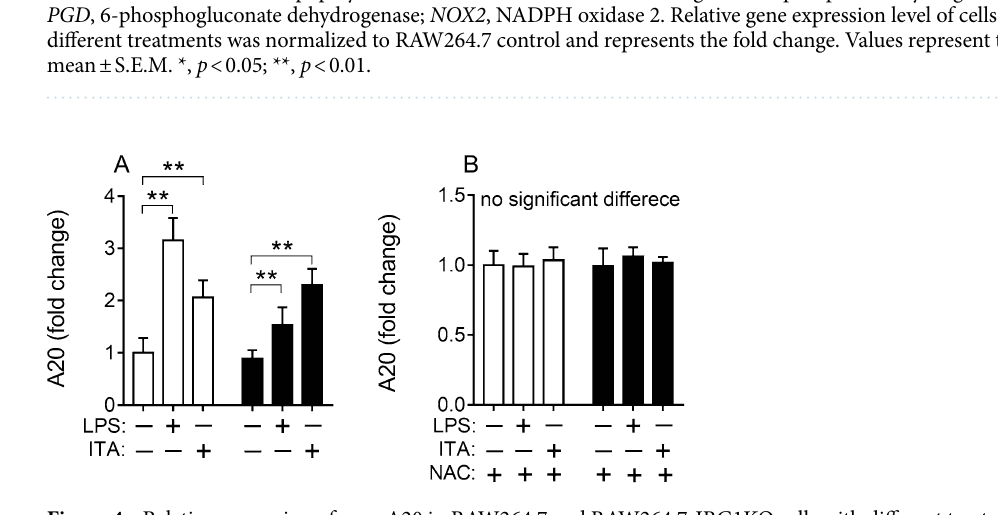
Figure 4. Relative expression of gene A20 in RAW264.7 and RAW264.7-IRG1KO cells with different treatments (24 h). White bar, RAW264.7; black bar, RAW264.7-IRG1KO. LPS, lipopolysaccharide; ITA, itaconic acid; NAC, N -acetyl-L-cysteine. A20, TNFAIP3 , TNF alpha induced protein 3. Relative gene expression level of cells with different treatments was normalized to RAW264.7 control and represents the fold change. Values represent the mean ± S.E.M. **, p <